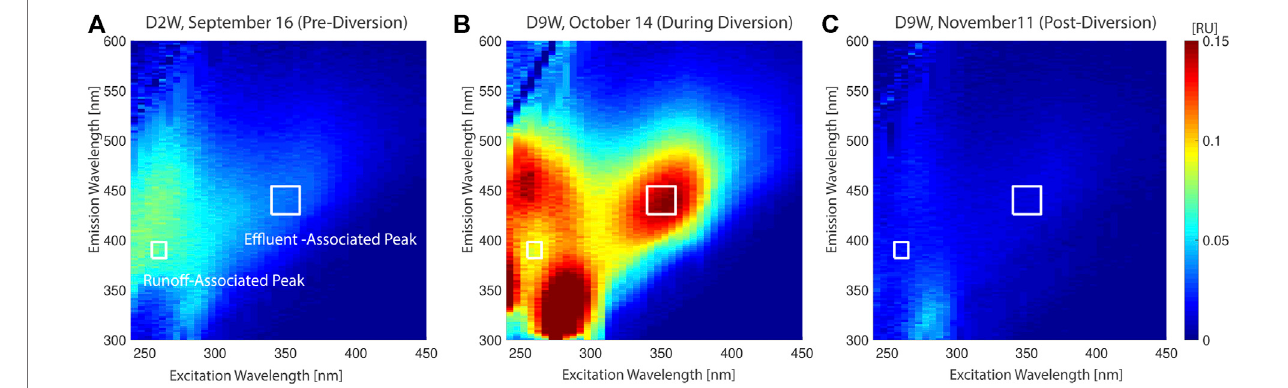
FIGURE 5 | CDOM fl uorescence excitation emission matrices (EEMs): (A) EEM of a pre-diversion sample with high a g (365) associated with terrigenous runoff that fl uorescesstronglyattherunoff-associatedpeak F – 265 nmexcitationand382 – 398 nmemission), (B) EEMofanef fl uent-impactedsample,collectedatthe1-mile R (255 outfall during the diversion, which exhibits a strong ef fl uent-associated fl uorescence peak F E (340 – 360 nm excitation and 426 – 454 nm emission) that is much less prominent in samples not in fl uenced by ef fl uent, (C) EEM of a low a g (365) sample collected at the 1-mile outfall after the diversion.